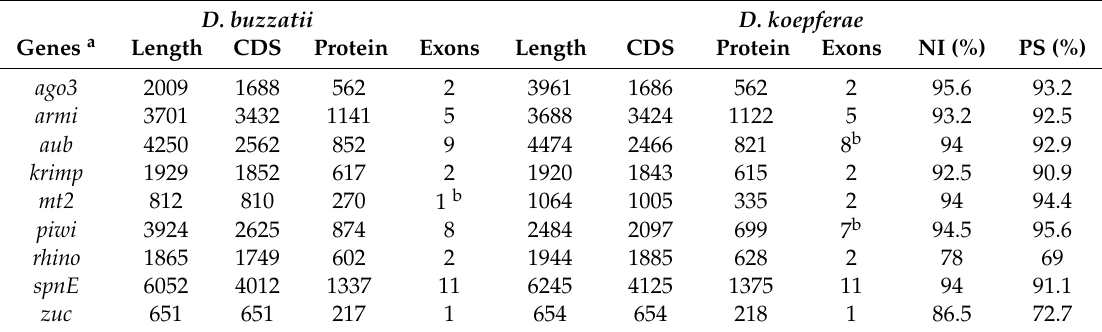
Table 1. Structure of the piRNA pathway genes sequenced